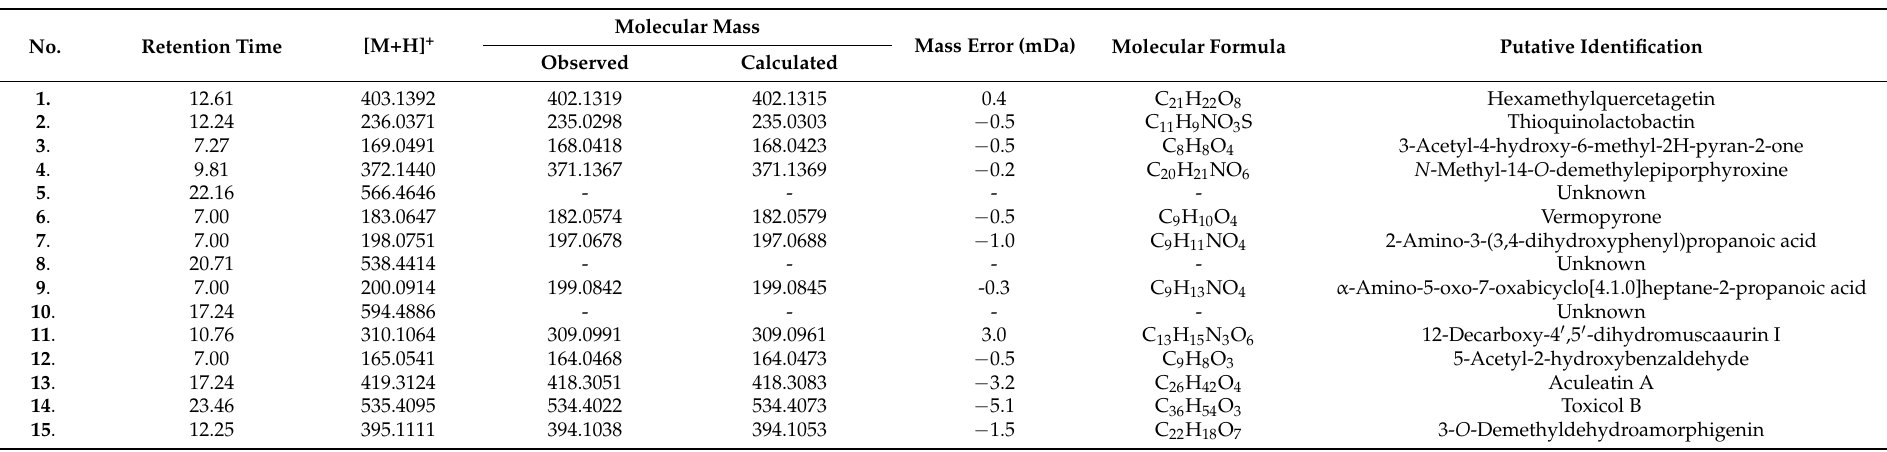
Table 2. Dereplication of discriminant putatively identified metabolites in DFC and DFS. The level of identification was L2—putatively identified metabolites through library matching